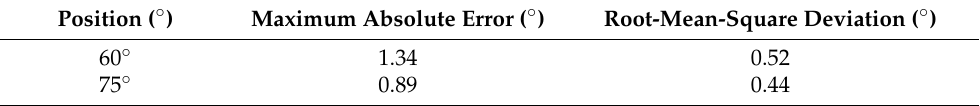
Table 6. Error in path-tracking control for the elbow joint.